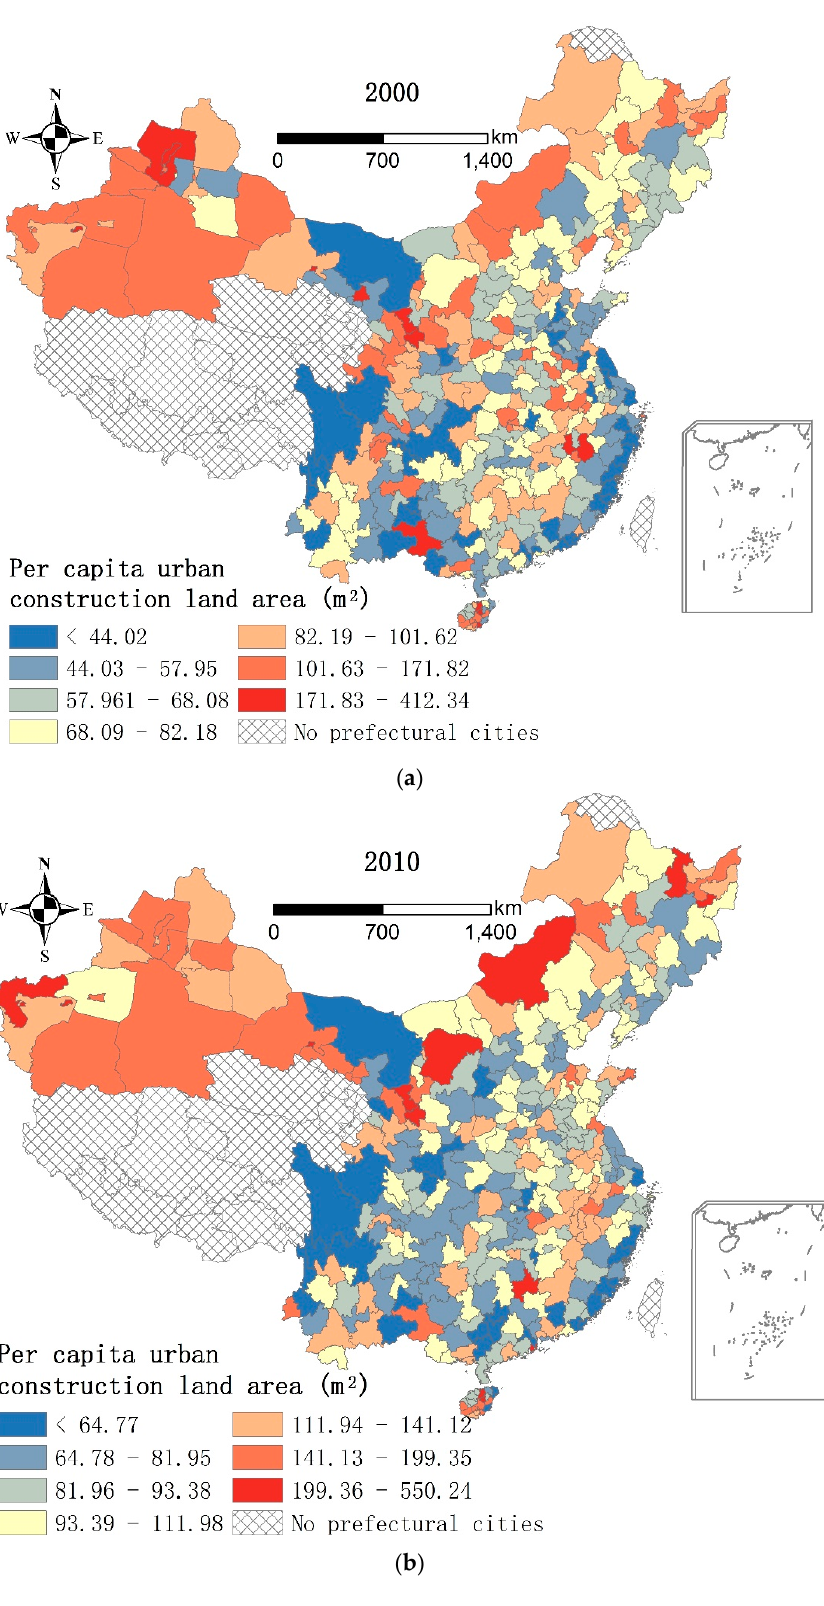
Figure 5. Per capita urban construction land area in the prefectural cities, China, 2000 and 2010. ( a ) Per capita urban construction land area in the prefectural cities, China, 2000; ( b ) Per capita urban construction land area in the prefectural cities, China, 2010.